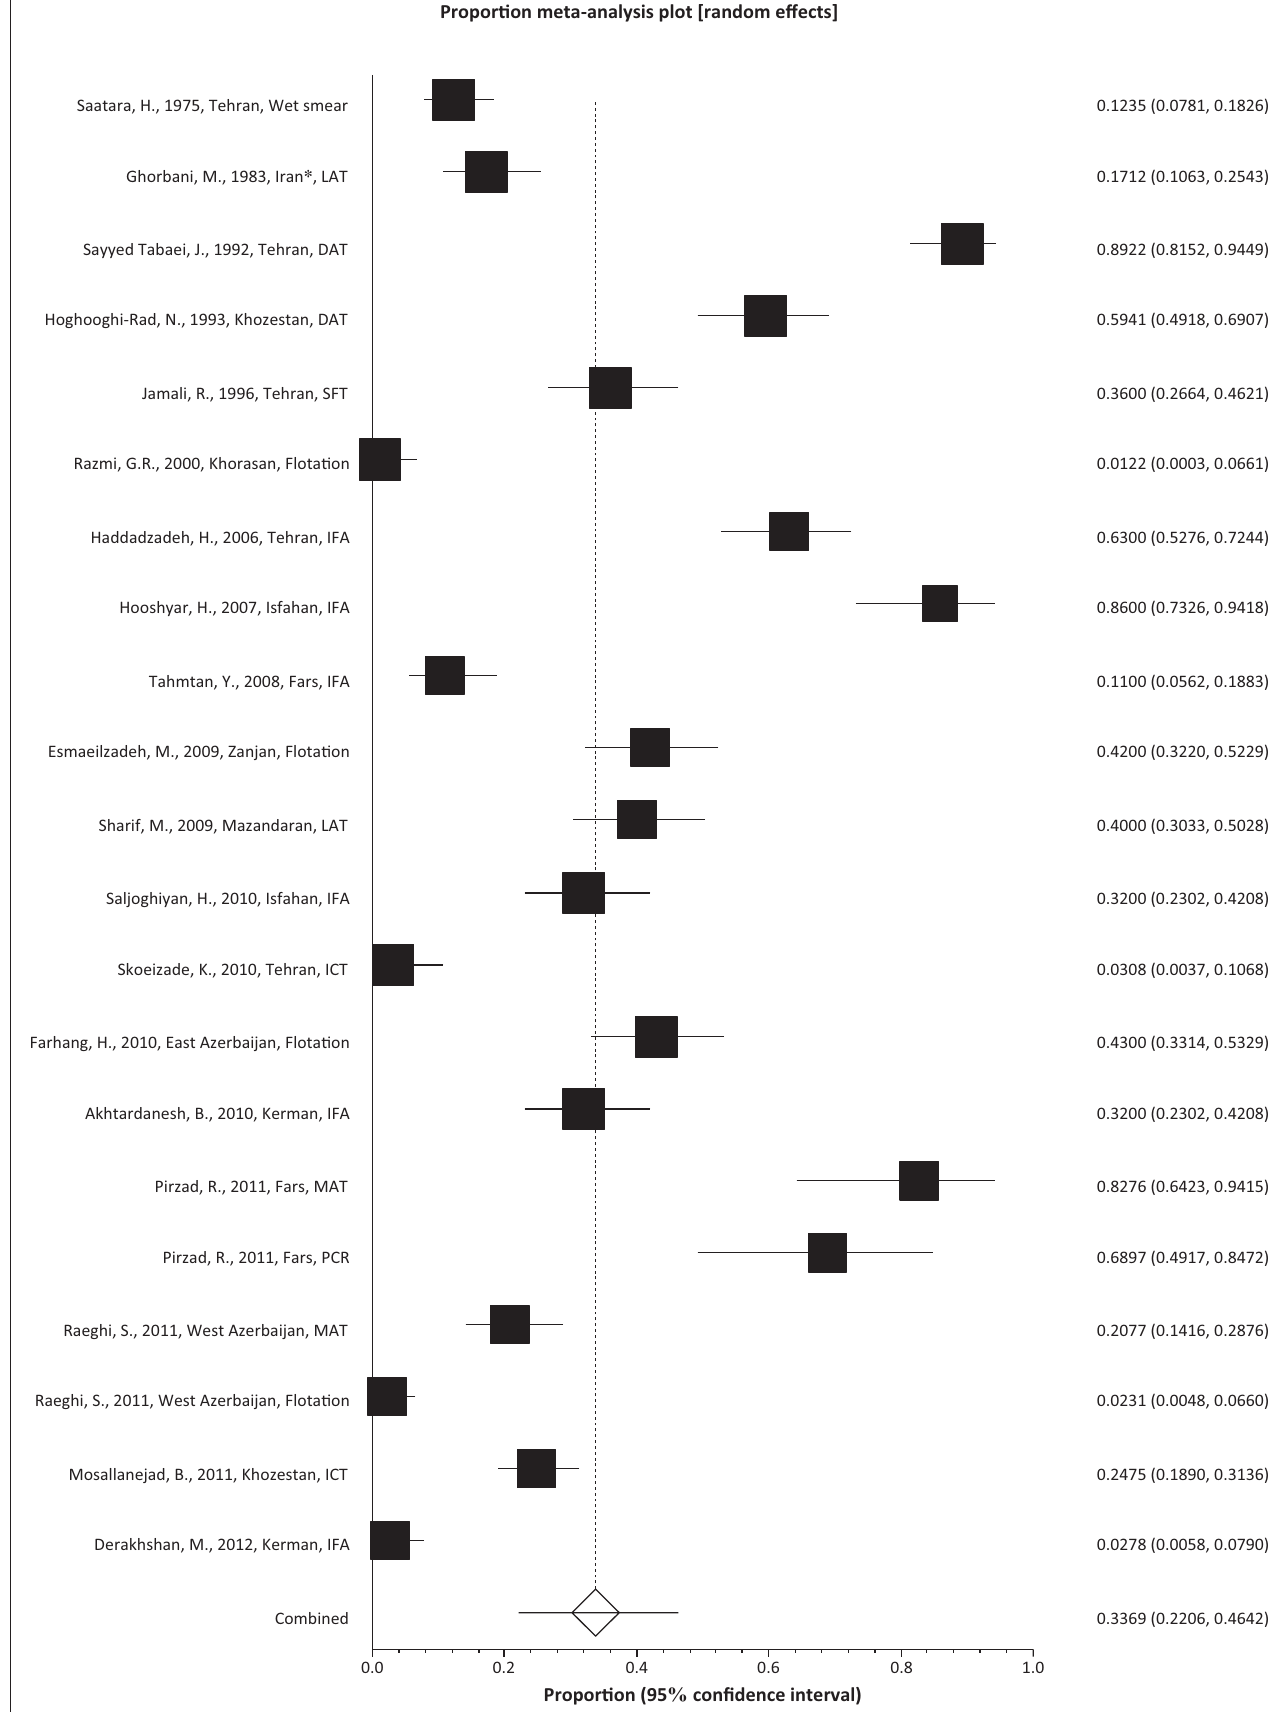
Propor(cid:27)on meta-analysis plot [random effects]